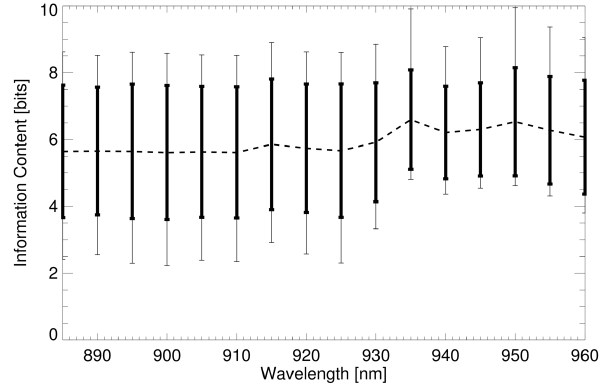
Fig. 9. Mean information content in 27 cases of different atmo- spheric circumstances concerning water vapour of a retrieval using two window channels (METimage: 865, 1020 nm) and an absorp- tion channel (width 10nm) (broad bars account for the standard de- viation of the cases).